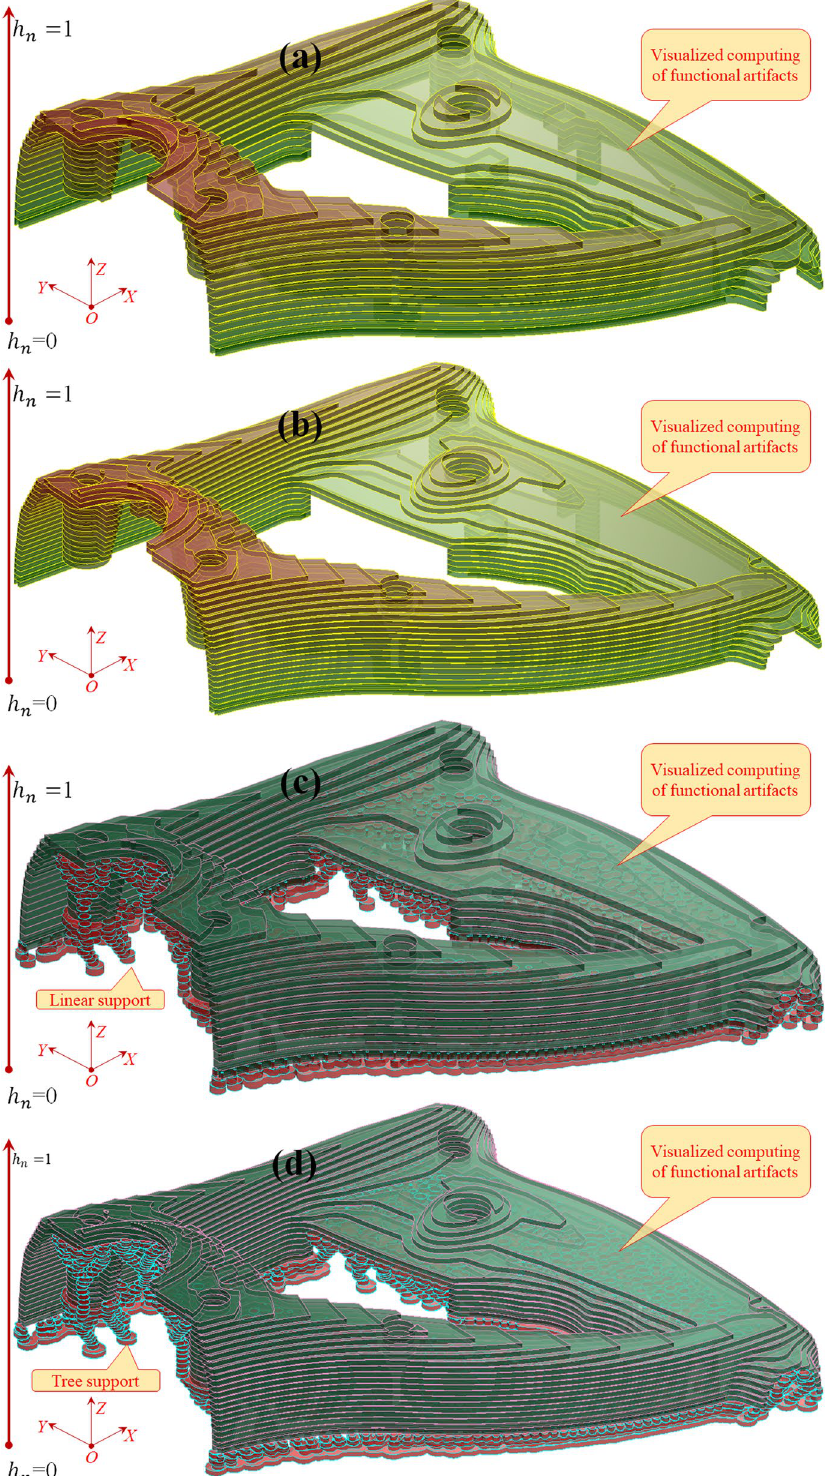
Fig. 10 Visualized virtual printing of fiber-reinforced composites using visual computing digital twins, from the front view, where a denotes 20 layers without support, b denotes 30 layers without support, c denotes 20 layers with tree support, and d denotes 30 layers with tree